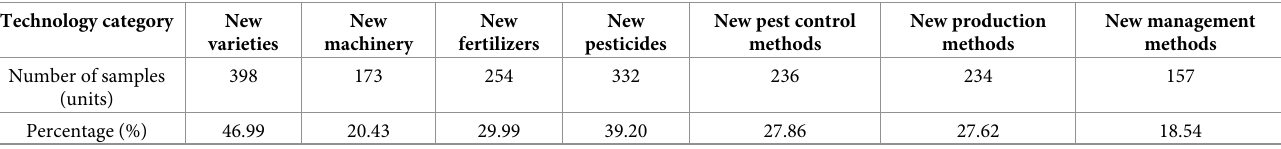
Table 2. Statistics of new agricultural technologies adopted by family